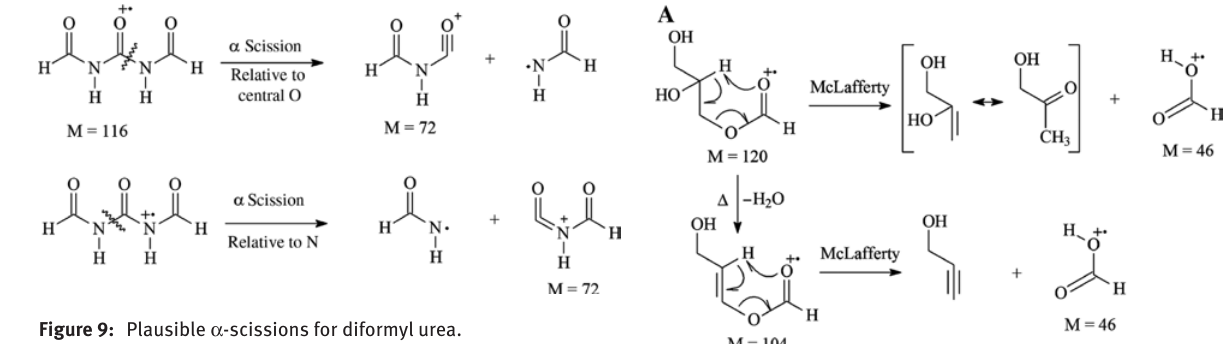
Figure 9: Plausible α -scissions for diformyl urea.